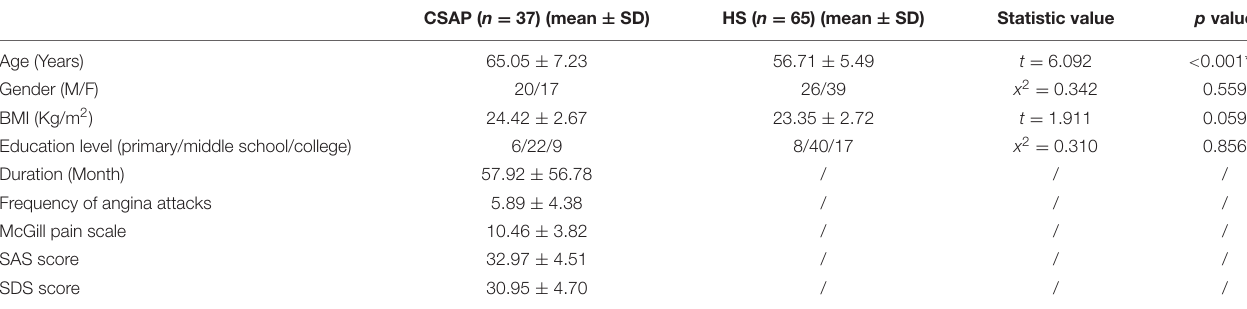
TABLE 1 | The demographic and clinical characteristics of CSAP patients and HS.